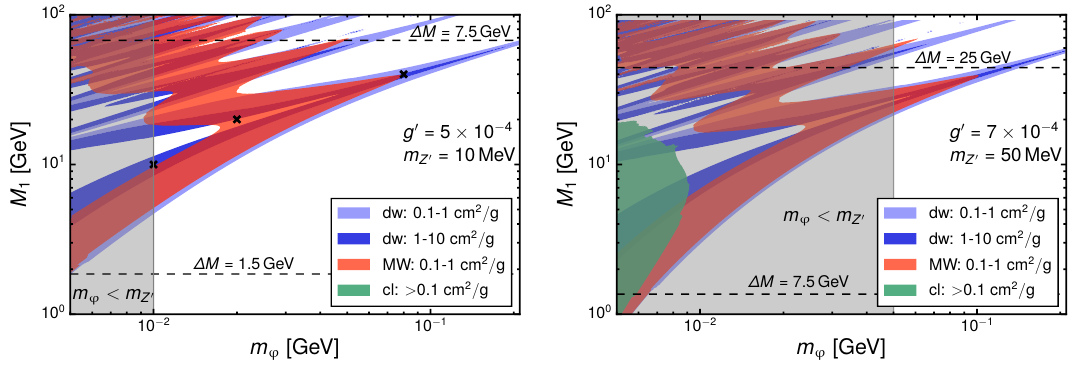
Figure 2 . SIDM parameter regions for dwarf galaxies (blue), Milky Way-size galaxies (red), and galaxy cluster (green). We take ( m Z 0 ; g In the left panel, the self-scattering cross section is less than 0 : 1 cm 2 = g in galaxy clusters. The BBN observations disfavor m ’ < m Z 0 (gray). The dashed lines indicate the mass splittings between N 1 and N 2 states. The crosses (left) denote the benchmark cases shown in (cid:12)gure 3.